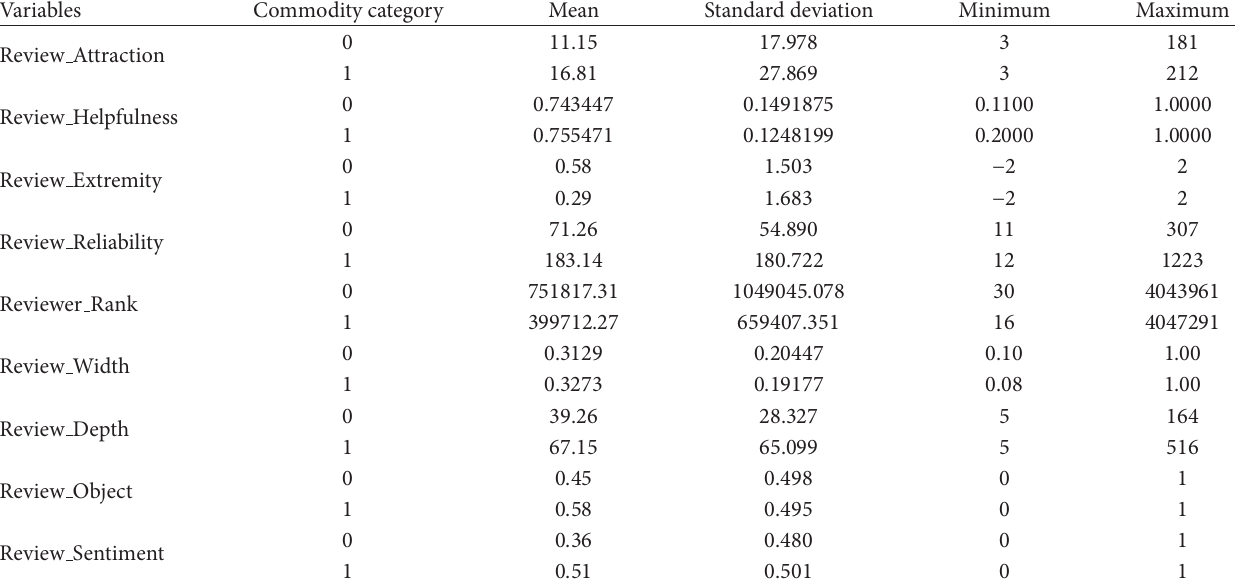
Table 4: Descriptive statistics of samples considering commodity